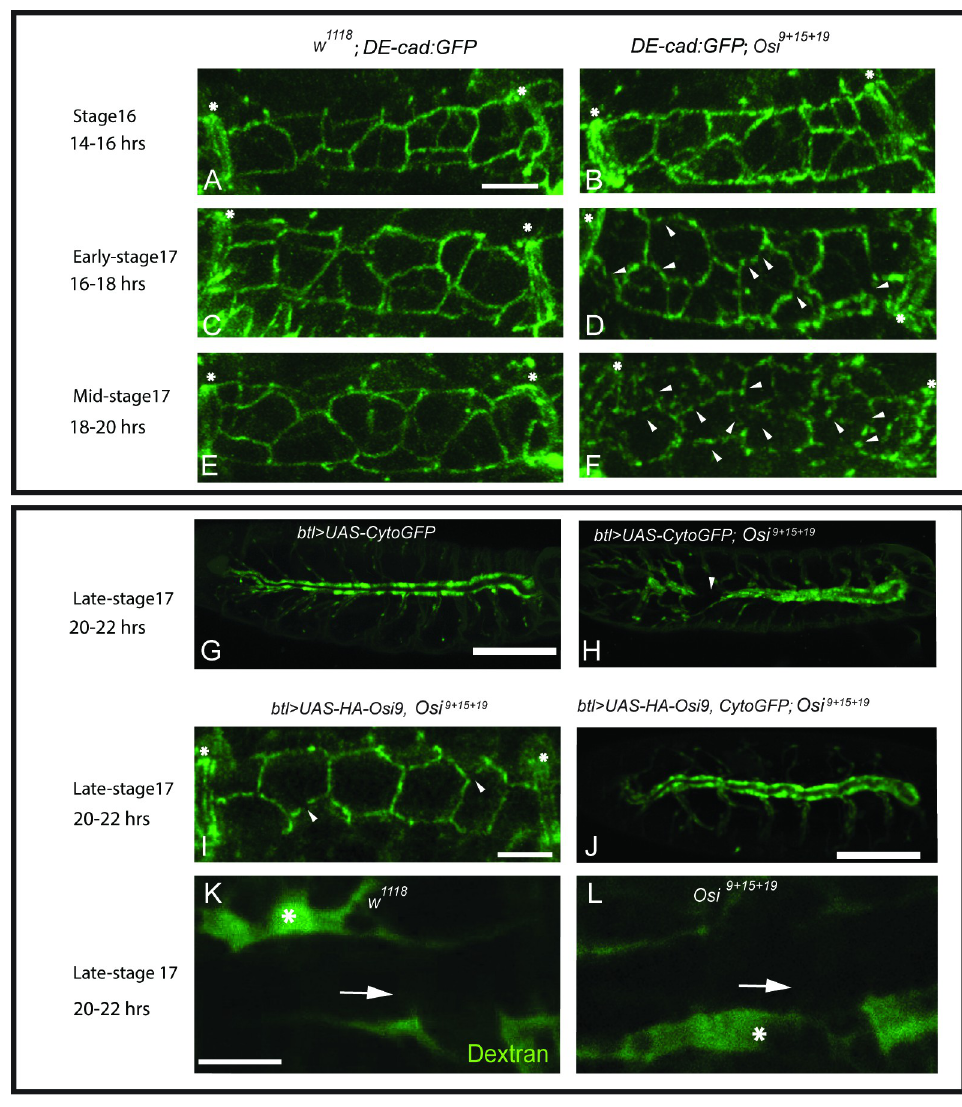
Fig 6. Osi genes are required for the maintenance of the AJs but not SJs. (A, C, E) Wild type DE-cad:GFP expression in green showed uniform localization along AJs throughout stage 16 and stage 17. (B, D, F). DE-cad:GFP expression in the Osi 9+15+19 triple mutant started to become discontinuous (breaks) at early-stage 17, and more breaks in each AJ were observed at mid-stage 17. (D, F) White arrows in each image pointed to breaks in the continuity of DE-cad:GFP expression. (A-F, I) White asterisks indicated fusion cell locations. (G-H) The cytoplasm of tracheal cells was outlined by btl > Cyto GFP at late-stage 17 embryos. (G) In wild-type embryos, there was a distinct region where the lumen was located. (H) In Osi 9+15+19 triple mutant, one or two tracheal gaps (white arrowhead) were observed on average. Attempts to rescue through Osi9 overexpression in the triple mutant background ( btl > UAS-HA-Osi9 , Osi 9+15+19 ) (I) showed DE- cad:GFP expression was rescued to near-wild type continuity with only a few breaks (white arrowheads) and (J) no obvious tracheal gaps were observed. (K-L) Dextran-FITC injection into late-stage 17 Osi 9+15+19 triple mutant and wild- type embryos showed that there were no defects in the barrier function of the SJs. Asterisks showed the neighboring tissues with dye present, while the white arrows pointed to the trachea that was devoid of dextran-FITC. The white scale bar in (A, I, K) represented 10 μ m and served as references for A-F, I, and K-L respectively. The white scale bar in (G, J) represented 100 μ m and served as references for G-H, and J respectively.